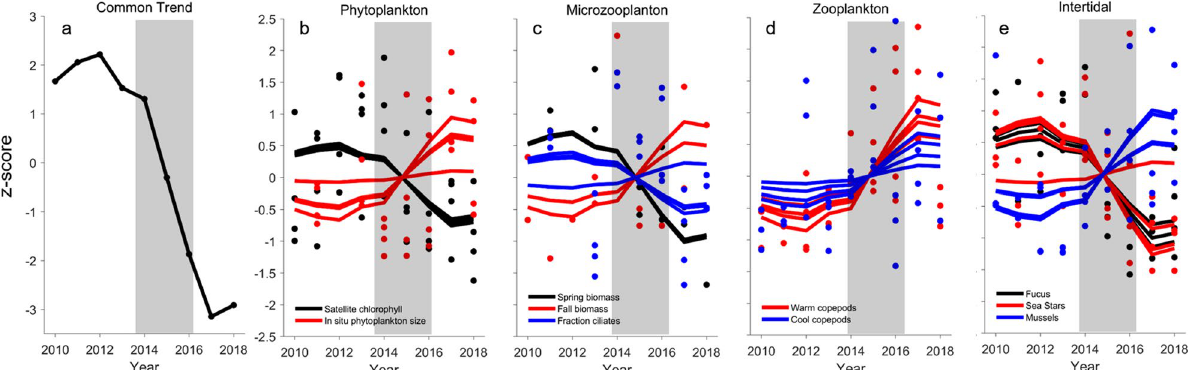
Figure 3. Response of lower trophic level species during the Pacific marine heatwave. ( a ) The common trend from the best model fit (lowest AICc; Table S2) identified from dynamic factor (DFA) analysis of 187 biological time series. ( b ) Phytoplankton indexed by satellite-derived chlorophyll biomass along the Seward and Kodiak oceanographic sampling lines and in situ measures of phytoplankton size composition from Seward Line sampling. ( c ) Microzooplankton seasonal biomass and fraction of ciliates from Seward Line sampling. ( d ) Zooplankton abundance for warm and cool water associated copepod species from continuous plankton recorder over oceanic and shelf waters and inside waters of Kachemak Bay and Prince William Sound. ( e ) Intertidal algal, sea star, and mussel abundance from four regions across the northern GOA. Points are annual values and solid line is DFA model fit to each time series. Grey shading represents the 2014–2016 northeast Pacific marine heatwave. Values are z-score standardizations so the y-axes are